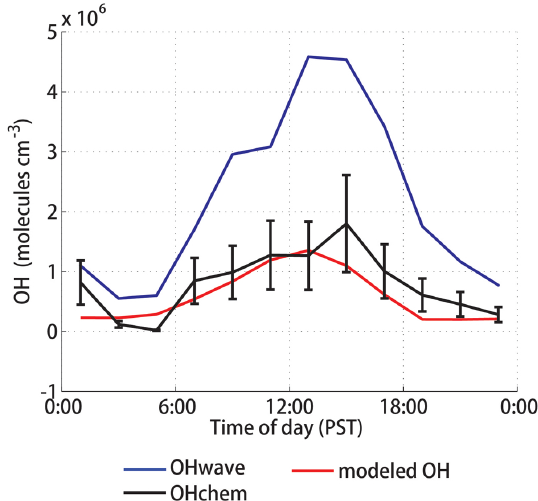
Figure 3. Example of OH measurement with an external mercury lamp (Hg lamp 1 in Fig. 3. Example of OH measurement with an external mercury lamp Figure 1) producing OH and periodic C 3 F 6 addition (3.3 sccm). The large OH value is (Hg lamp 1 in Fig. 1) producing OH and periodic C 3 F 6 addition when C 3 F 6 is not added and the small value occurs when it is. The removal efficiency for (3.3sccm). The large OH value is when C 3 F 6 is not added and the this example is 94%. small value occurs when it is. The removal efficiency for this exam- ple is